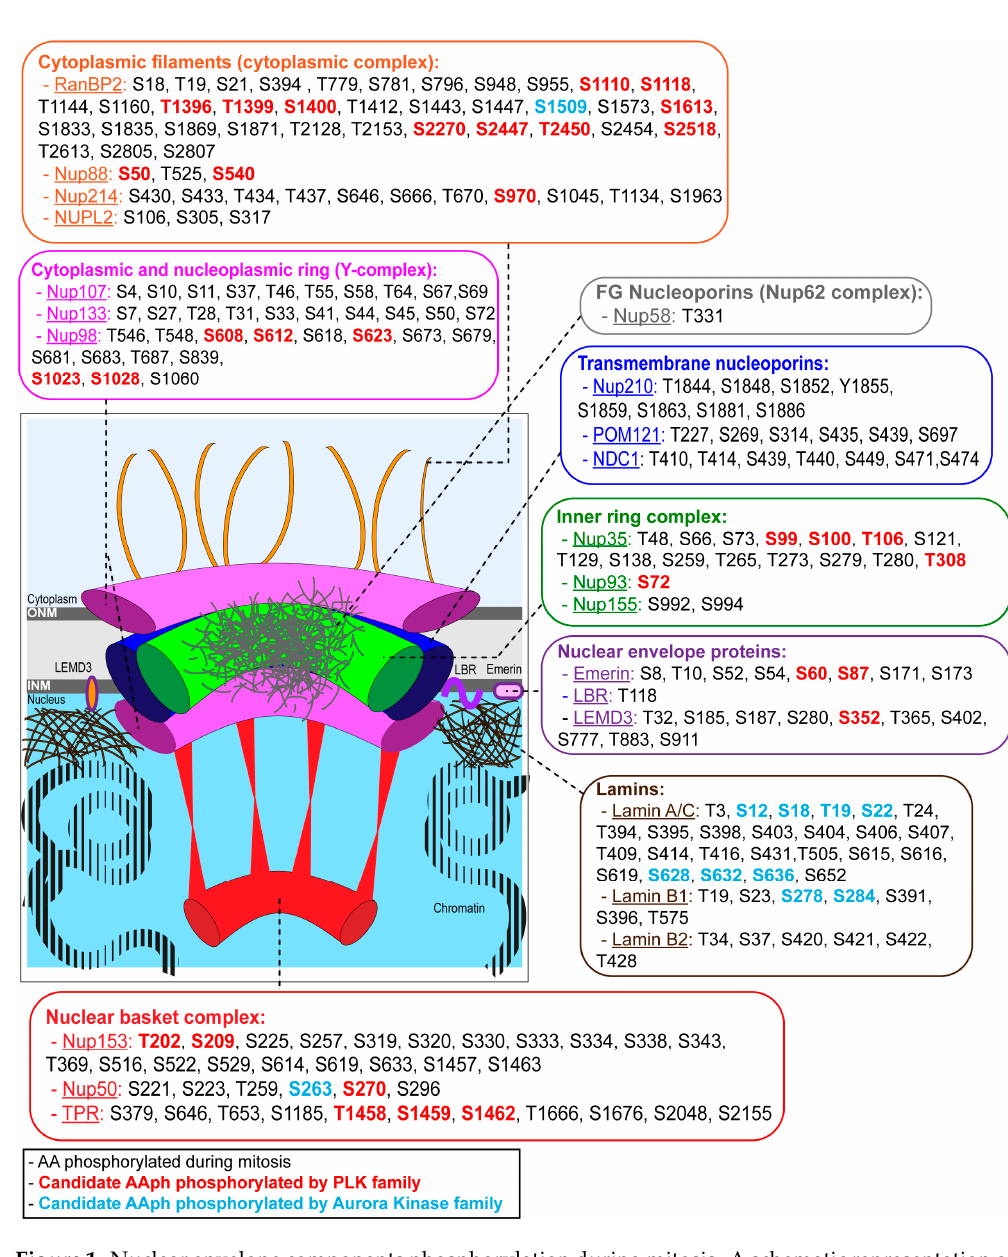
Figure 1. Nuclear envelope components phosphorylation during mitosis. A schematic representation of the nuclear pore complex (NPC) and its interactions with nuclear membranes (outer nuclear membrane (ONM) and inner nuclear membrane (INM)), lamins (in brown) and NE proteins (in purple). NPCs are composed by nucleoporins (NUPs) belonging to different subcomplexes: Y-complex (cytoplasmic and nuclear ring) (in pink), transmembrane NUPs complex (in blue), inner ring complex (in green), Nup62 complex (in grey), and nuclear basket complex (in red). During open mitosis, the nuclear envelope breaks down to allow chromosome segregation. This process is driven by phosphorylation. The mitosis-specific phosphorylated amino acids (AA) for each NUPs are listed based on published phosphoproteomic studies [21,22], together with the candidate kinases (PLK family in red and Aurora kinase family in blue) as identified in [23]. LBR: Lamin-B receptor; LEMD3: LEM domain-containing protein 3; NUPL2: Nucleoporin-like protein 2; POM121: Pore membrane protein 121kDa; RanBP2: Ran-binding protein 2.